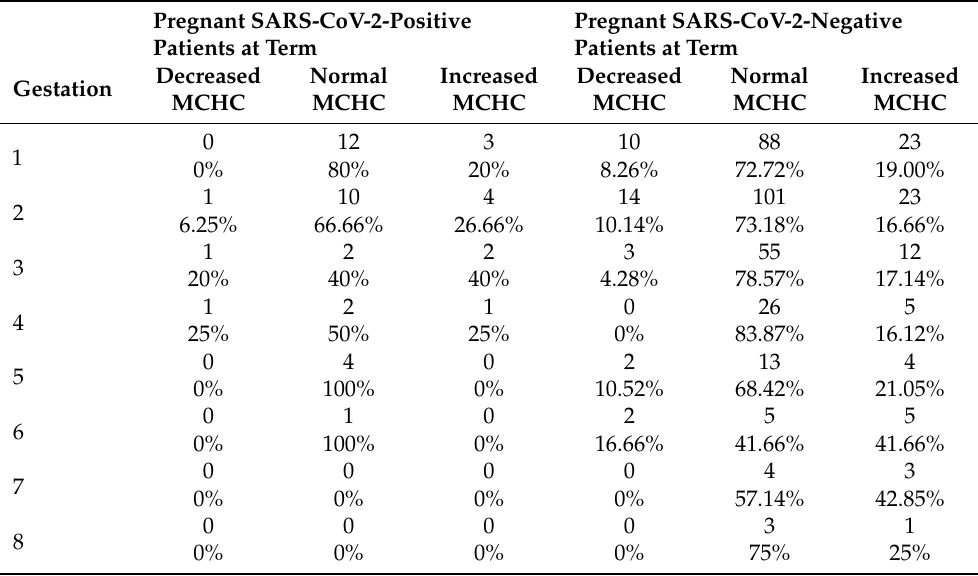
Table 13. Number and percentage of pregnant patients with normal, increased, and decreased values of MCHC, as regards